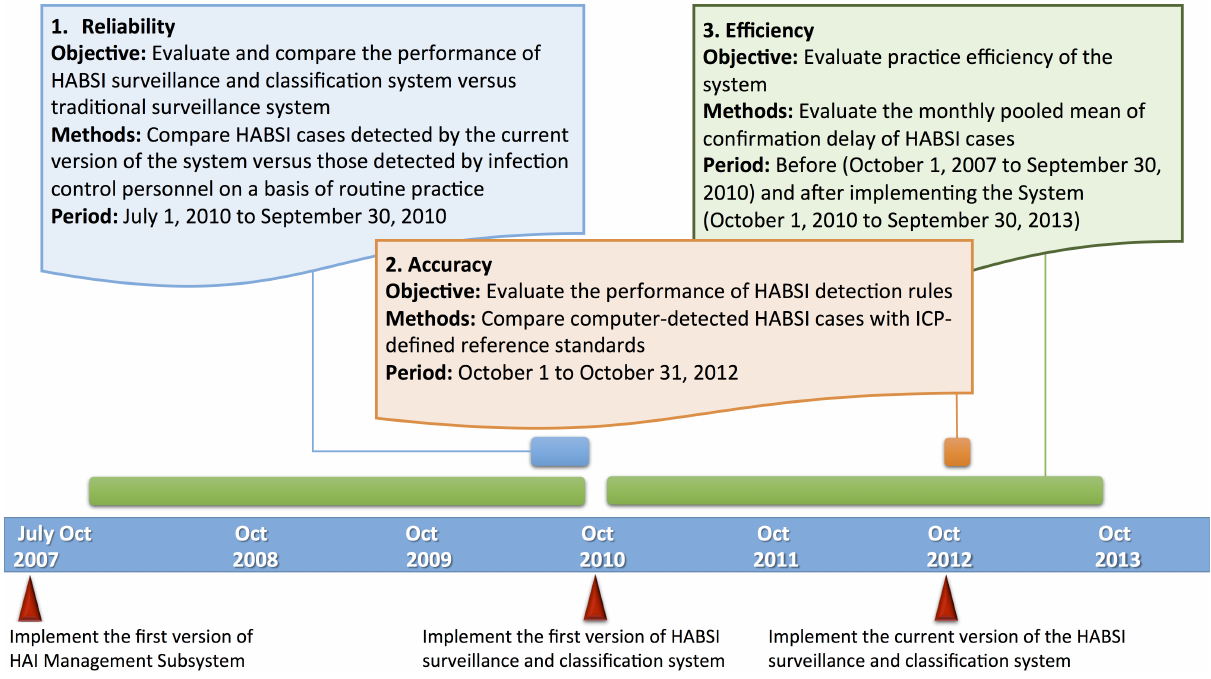
Figure 3. Timeline of development and performance evaluation of the health care-associated bloodstream infections (HABSIs) surveillance and classification system. ICP: infection control